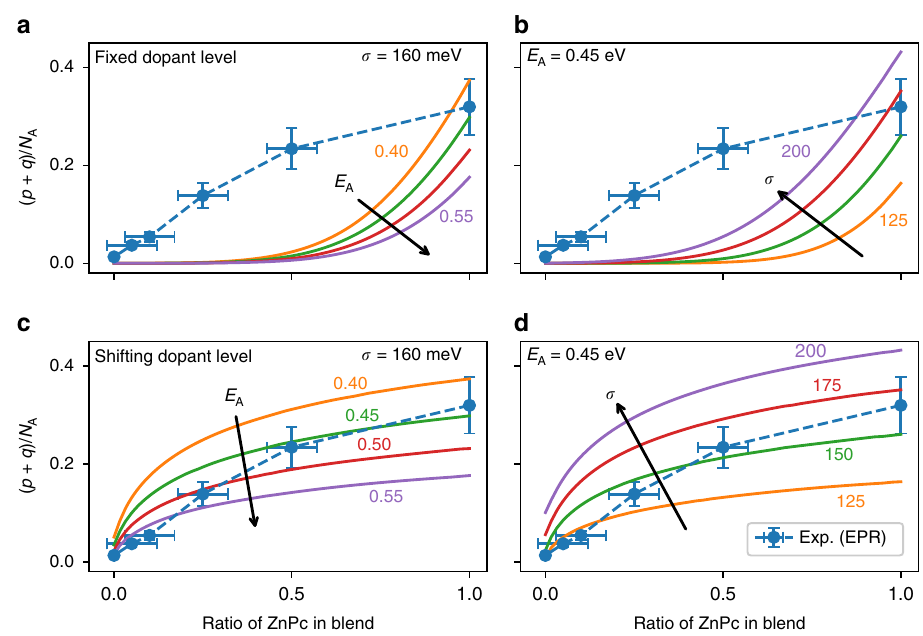
Fig. 4 Statistical model comparison to EPR. Comparisons of the experimentally measured doping ef fi ciency and the statistical models against weight ratio of ZnPc in the host blend, with the centre of the dopant ’ s DOS E and standard deviation σ varied independently. For the case where the dopant level is A fi xed: a shows variations in E = 0.45 eV. For the case where the dopant energy level shifts: c shows with σ = 160 meV and b shows variations in σ with E A A = 0.45eV. The doping ef fi ciency as determined via EPR is shown on all fi gures, with the the variation in E with σ = 160 meV and d variations in σ with E A A error bars representing the uncertainty in the spectral simulations and material deposition line. All states below the Fermi level are occupied (shaded) whilst the states above are unoccupied (unshaded). Figure 3a shows the fi rst case with the position of dopant energy level fi xed. The Fermi level shifts to lower energy as the content of ZnPc in the host